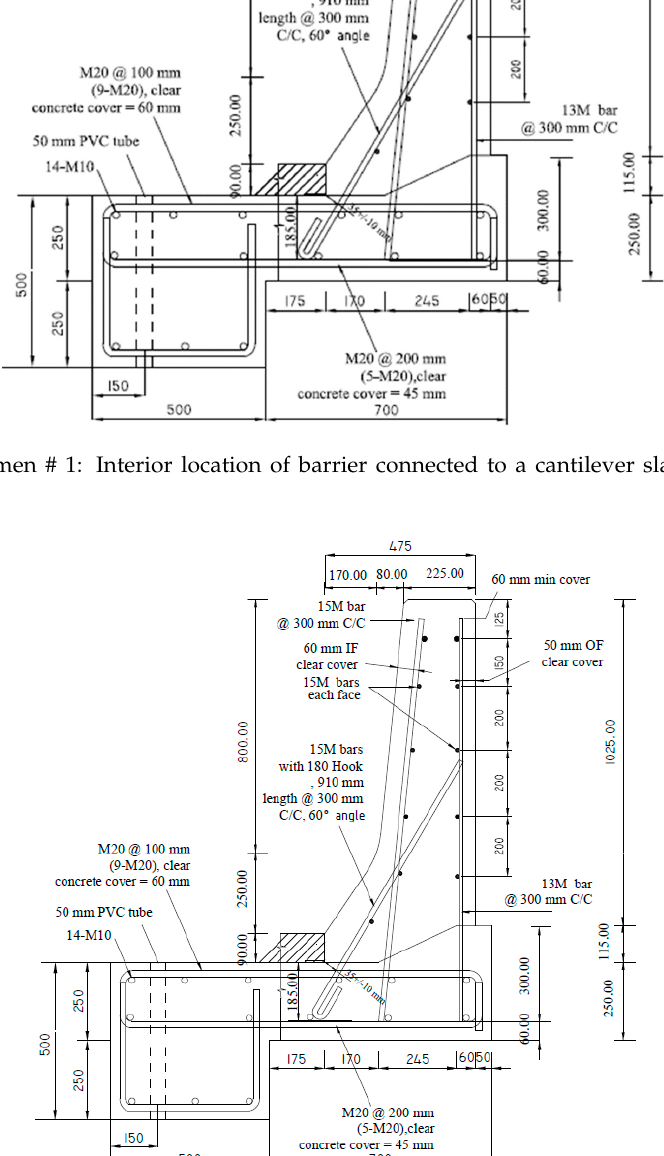
Figure 5. Specimen # 3: End location of barrier connected to a cantilever slab.